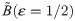
Overlay plot matrix of number of errors vs. kNN, representing a total of 1800 Laplacian mixture modeling algorithm runs.Noisy interpolating cluster graph matrices B˜(ε=1/2) were randomly generated for each run. Markers represent sample averages of labeling error numbers, after assigning each vertex to one of the 5 mixture components identified. Marker sizes correspond to uniform noise level α as indicated by the marker key on top of the plot matrix. Error bar lengths indicate one sample standard deviation. Colors correspond to the different log-linearly spaced cluster sizes (2, 17, 142, 1190, 104) as labeled. Columns correspond to different values of kmin, the minimum strongly-connected neighbor number. Outlier noise level indicated by Nout parameter separating upper and lower sections of the plot matrix.